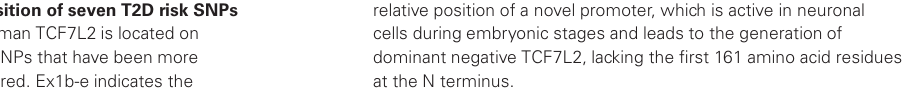
FIGURE 7 | Depiction of the position of seven T2D risk SNPs in the human TCF7L2 gene. Human TCF7L2 is located on chromosome 10q25.3. The two SNPs that have been more extensively studied are shown in red. Ex1b-e indicates the